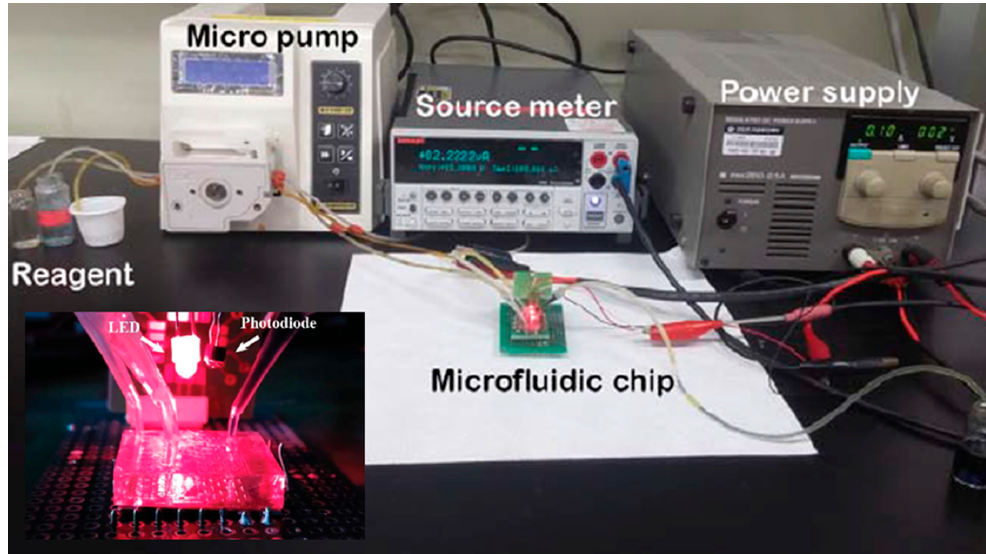
Figure 11. Instrument set-up for the proposed glucose sensor.